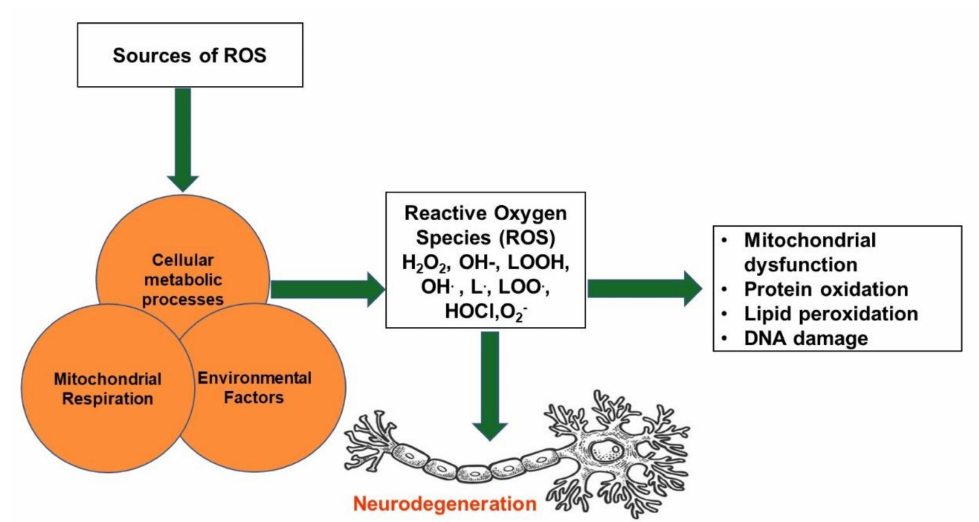
Figure 3. Oxidative stress and its effects on neurodegeneration. The introduction of various sources led to the production of reactive oxygen species causing neurodegeneration, which leads to DNA damage and mitochondrial dysfunction. H 2 O 2 , hydrogen peroxide; OH-, hydroxide; LOOH, lipid hydroperoxides; OH • , hydroxyl radical; L • , lipid radical; LOO • , peroxy radical; HOCl, hypochlorous acid; O 2 − , superoxide